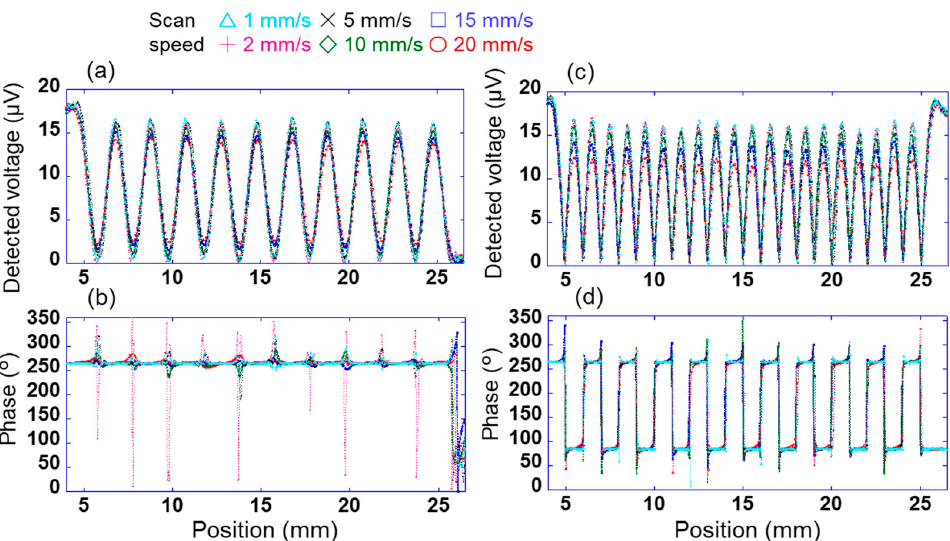
Figure 6. Changes in signal detected using sensor s10 through the lock-in amplifier with scanning speeds of 1–20 mm/s. Changes in voltage detected using the sensor when the applied voltages to sample 2 are ( a ) AV 1 = 100 V and AV 2 = 0 V (pattern 1) and ( c ) AV 1 = 100 V and AV 2 = − 100 V (pattern 2). Changes in phases detected using the sensor when the applied voltages to sample 2 are ( b ) pattern 1 and ( d ) pattern 2.